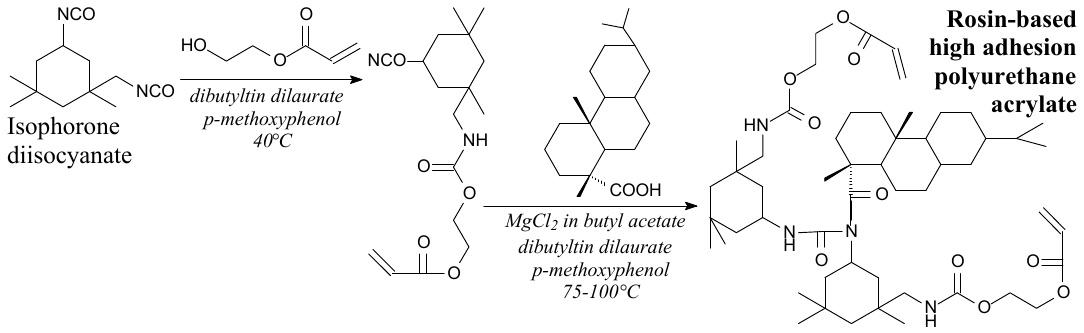
Scheme 14. Synthesis of rosin-based high adhesion polyurethane acrylate.